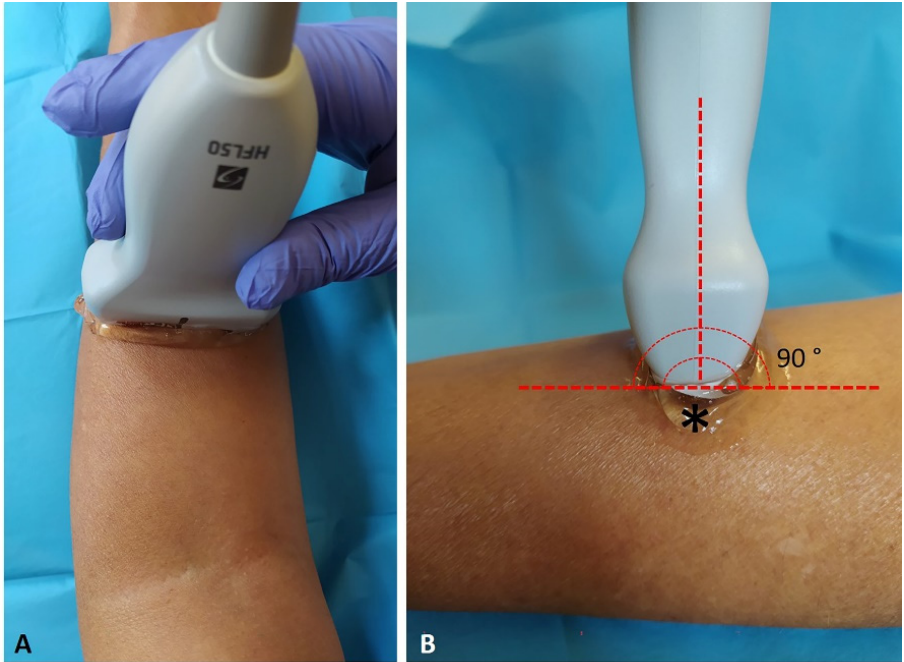
Figure 1. The probe position during the ultrasound (US) imaging assessment of the superficial fascia. ( A ): the anterior region of the forearm (Ant 1); ( B ) for adequate scans and to reduce surface pressure on the skin, the ultra-sonographer used suitable amounts of gel (*), and the US beam was kept perpendicular to the fascial layers.